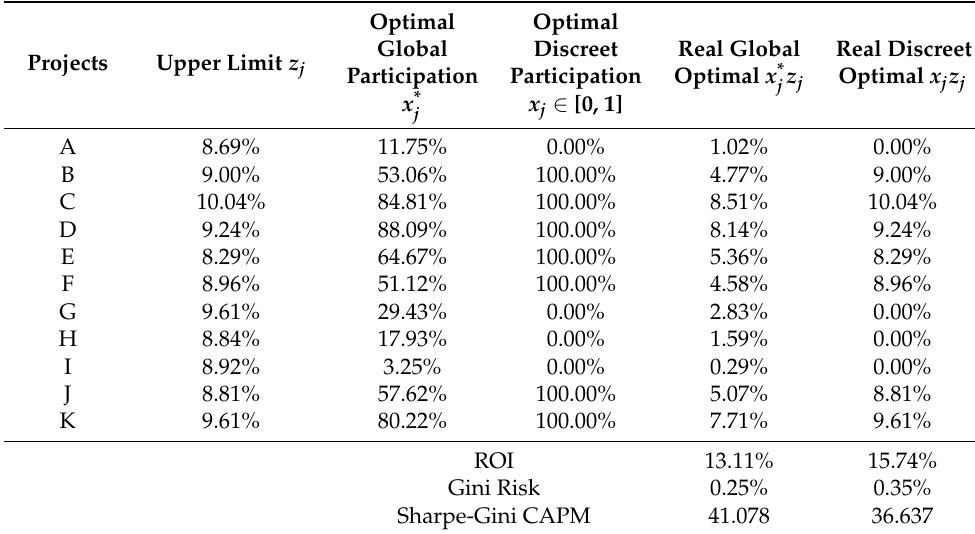
Table 4. Optimal global